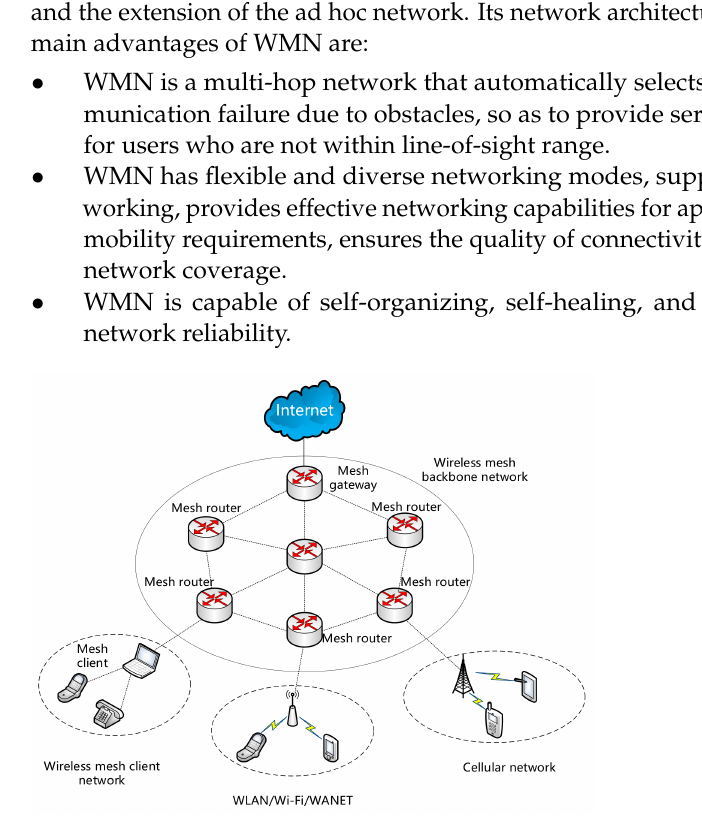
Figure 2. Structure diagram of